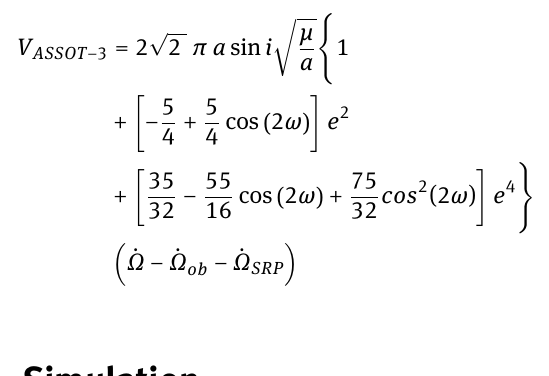
Figure 3. ˙ Ω ob / ˙ Ω SRP vs. semimajor axis and inclination.